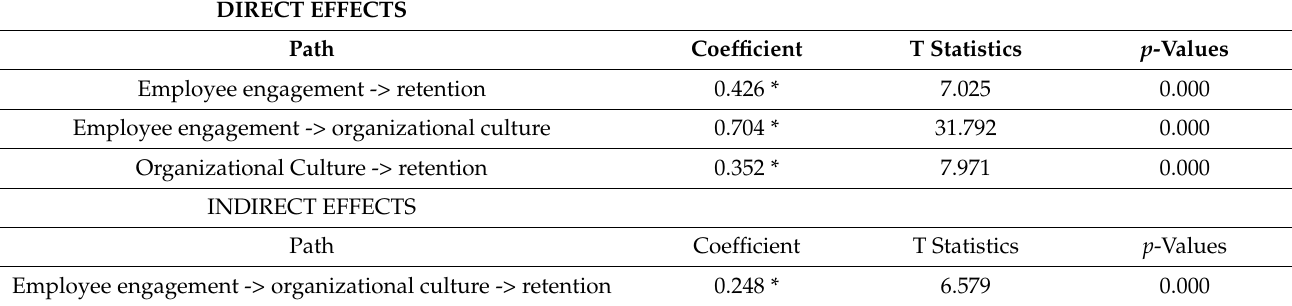
Table 6. Path coefficients of structural